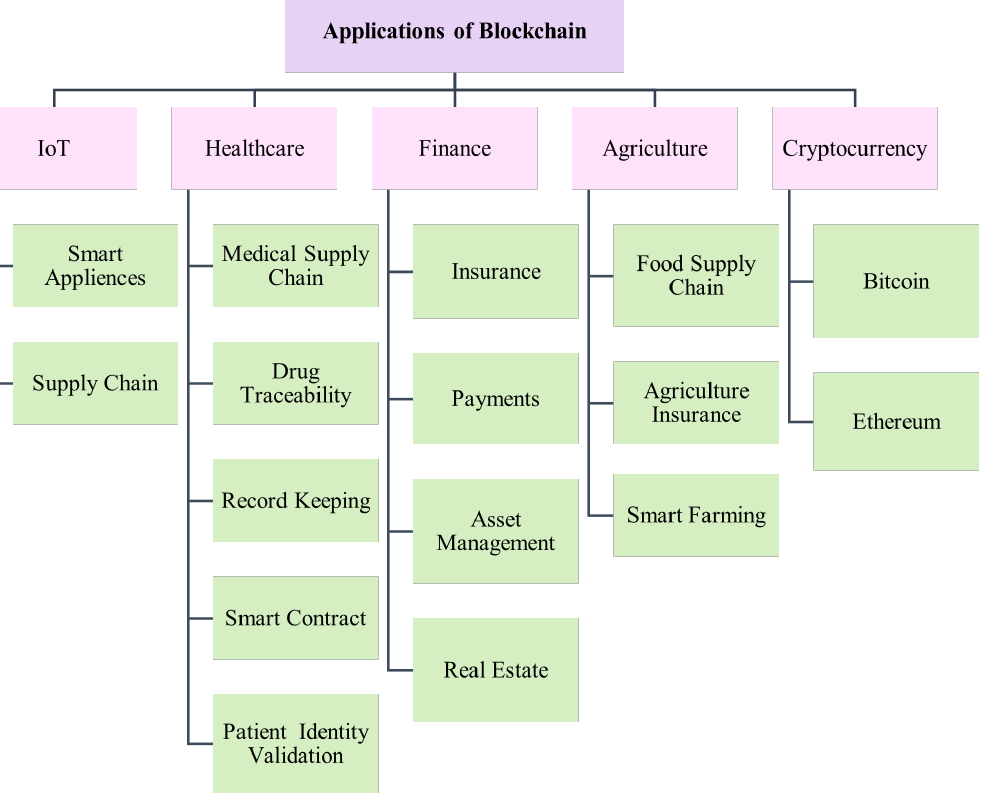
Figure 5. Applications of